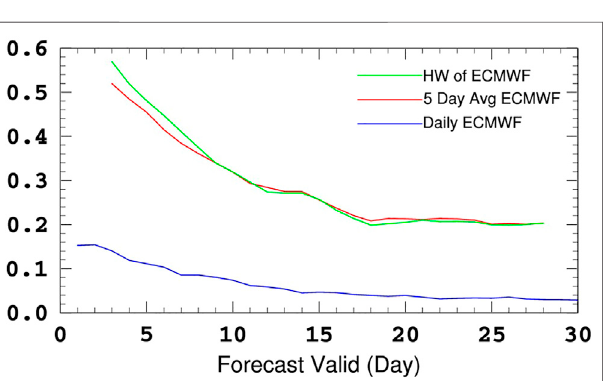
FIGURE 4 | The ETS of ECMWF for daily maximum air temperature greater than 35 ° C (blue line), 5-days running average of daily maximum temperature (red line), and HWI (green line) greater than their relative thresholds.